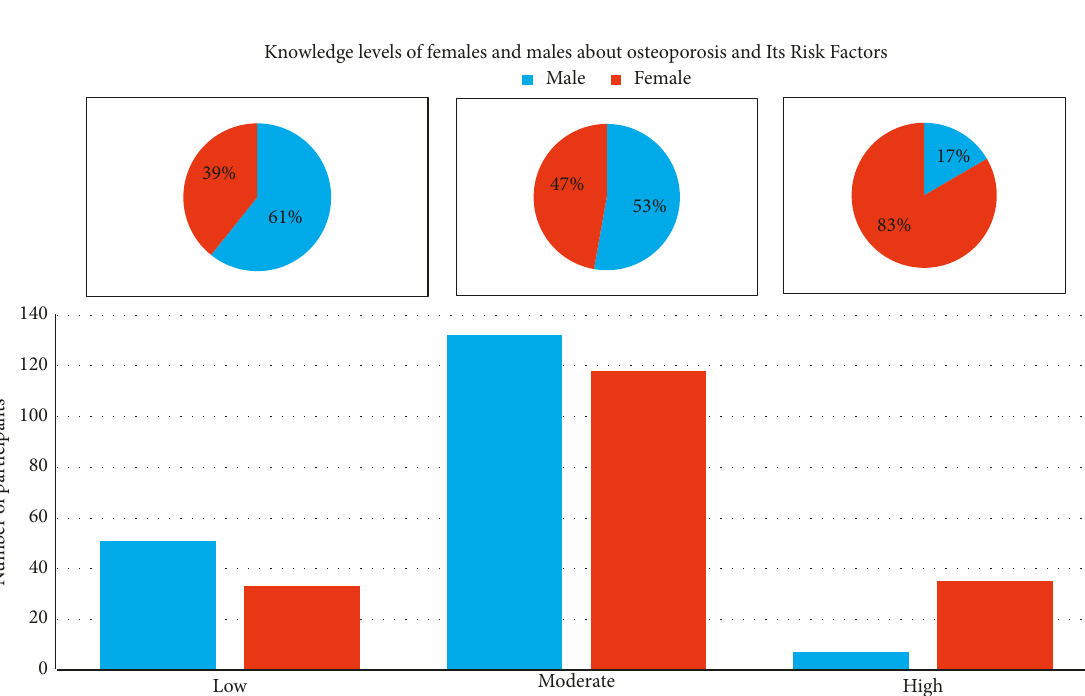
Figure 3: Knowledge about vitamin